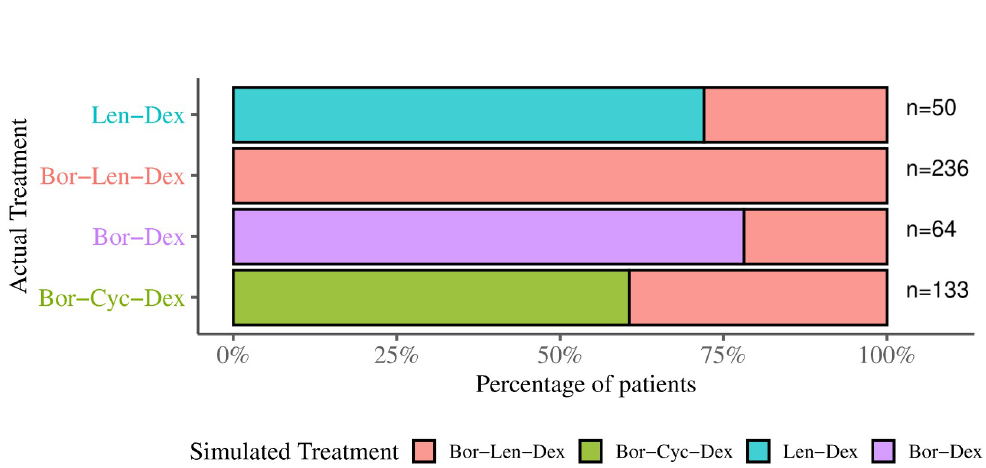
Fig 6. For each actual treatment (y-axis), we performed a simulation to identify the treatment (stacked bar colors) that maximizes the TS score considering the clinical and molecular data of MMRF cohort. The percentage of patients associated with a simulated treatment is shown on the